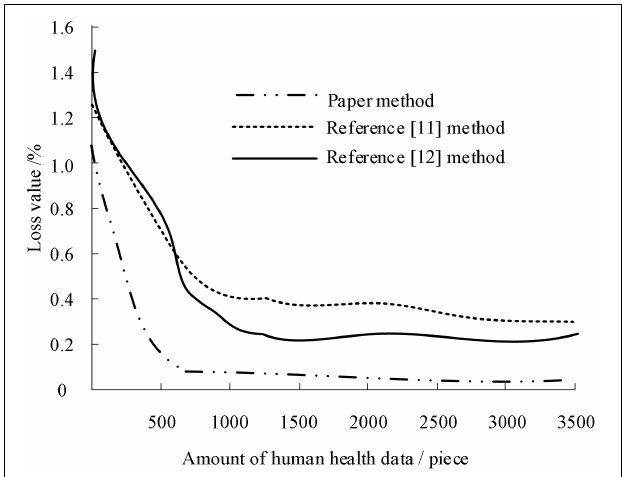
FIGURE 10 | Comparison results of the amount of data that can be controlled by the three